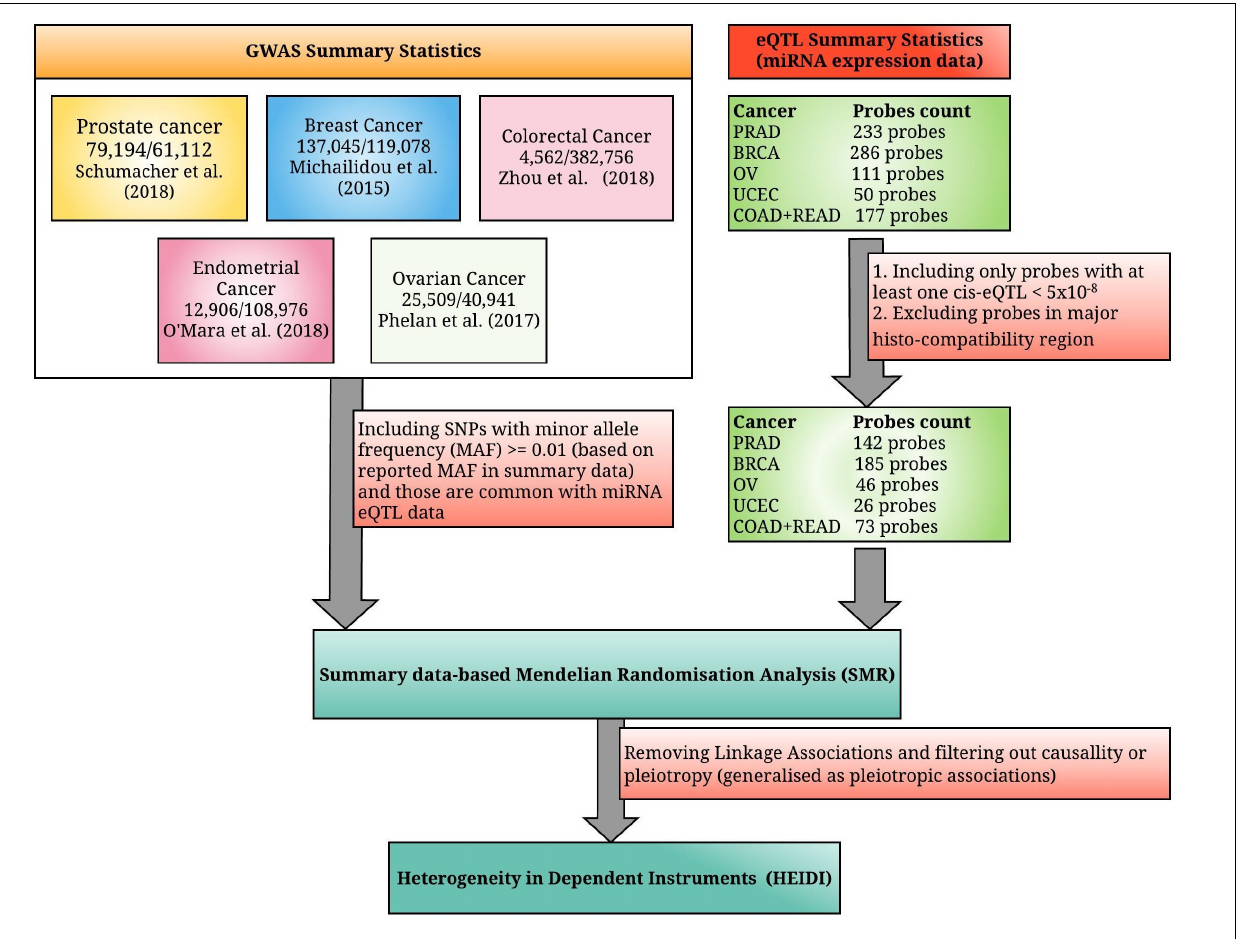
FIGURE 2 | A summarized diagram for the analytical framework used in this study. We have integrated the genome-wide association studies (GWAS) summary statistics for the five most common hormone-dependent cancers (HDC) and microRNA expression quantitative trait loci (miRNA eQTL) summary statistics from the non-coding RNAs (ncRNA)-eQTL database, where the original miRNA expression data were collected from the miRNA-seq data of the Cancer Genome Atlas (TCGA). TCGA study names PRAD (prostate adenocarcinoma), BRCA (breast invasive carcinoma), OV (ovarian serous cystadenocarcinoma), UCEC (uterine corpus endometrial carcinoma), COAD (colon adenocarcinoma), and READ (rectum adenocarcinoma) denote prostate cancer, breast cancer, ovarian cancer, endometrial cancer, colon cancer, and rectal cancer, respectively (the combined miRNA eQTL data of colon and rectal cancers are considered as colorectal cancer eQTL